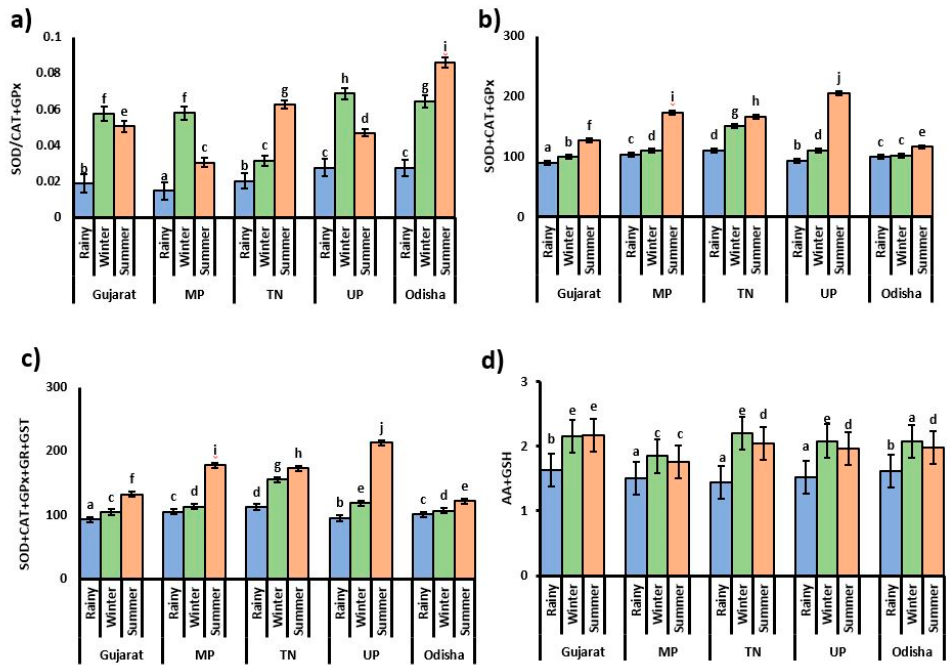
Figure 4. Relationship between different components of antioxidant defense system and season ( a – d ). The data represent mean ± SEM with superscripts indicating statistical differences between mean values at the p < 0.05 level.